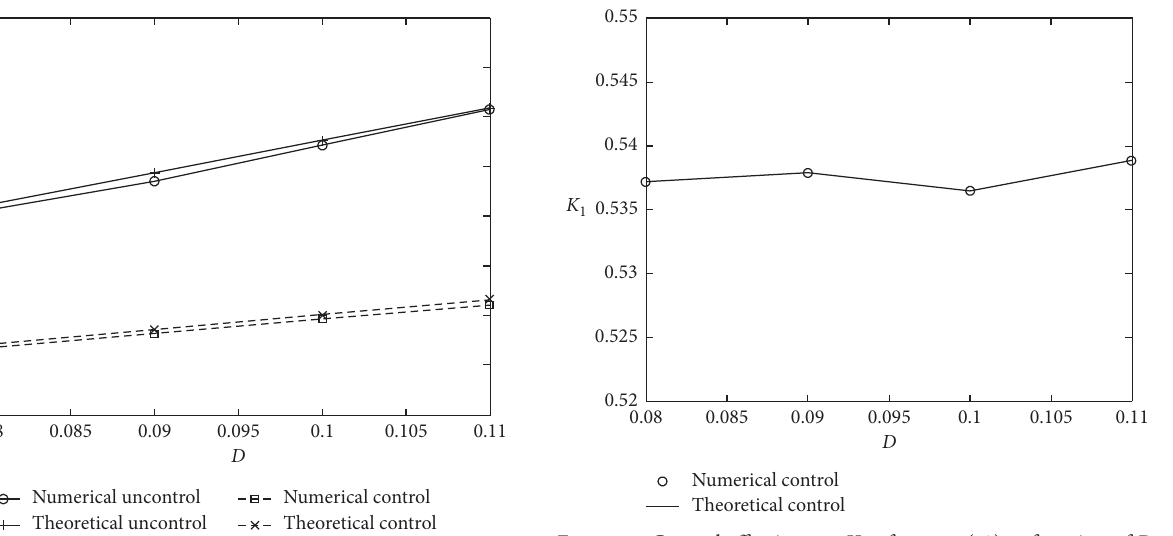
] of system (10) as function of D . 1